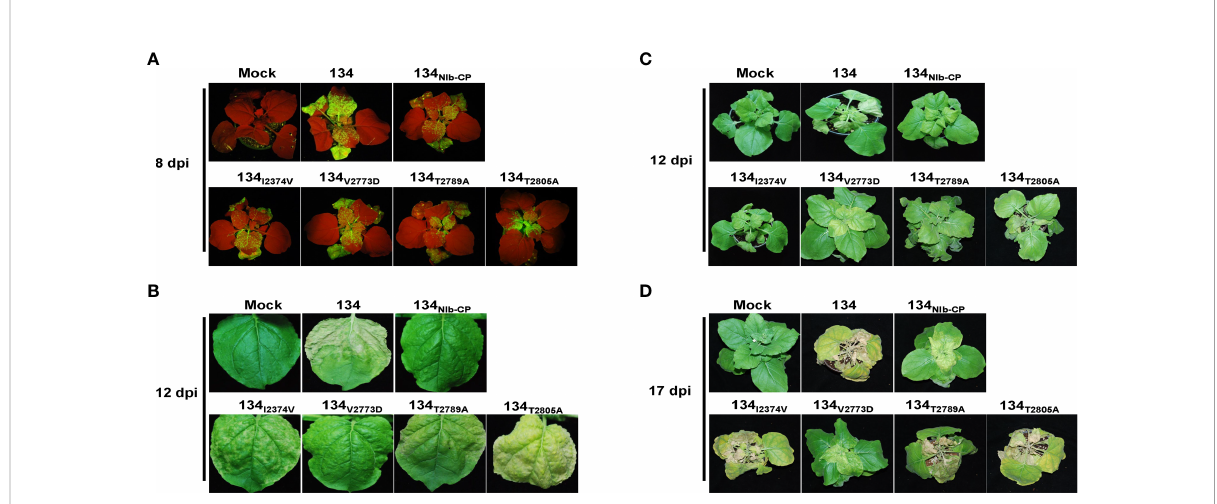
FIGURE 7 Virus replication and symptom development of 134 and substituted mutants on local and systemic leaves. PepMoV-134 and substituted mutants were inoculated onto N. benthamiana plants by agro-in fi ltration. The plants age used for inoculation is around 3 weeks old. The viral RNA accumulation difference among 134 and mutant viruses was monitored obviously for 5 days post-inoculation. (A) Observation of GFP expression on inoculated leaves at 8 dpi. (B) Results from systemic leaves at 12 dpi. Symptoms development of 134 and substituted mutants at 12 dpi (C) and 17 dpi (D)